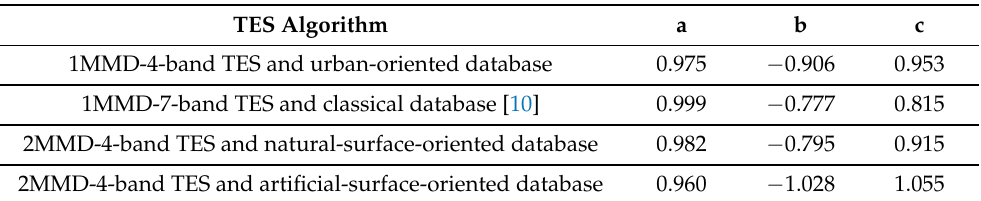
Figure 8. MMD relationship statistical fits for the 2MMD TES: artificial-surface-oriented database ( up ), natural-surface- oriented database ( bottom ) calibration ( left ), validation ( right ). The obtained MMD relationship is higlighted with a red line. Table 3. Coefficients a , b and c for the MMD relationship according to the database and the number of